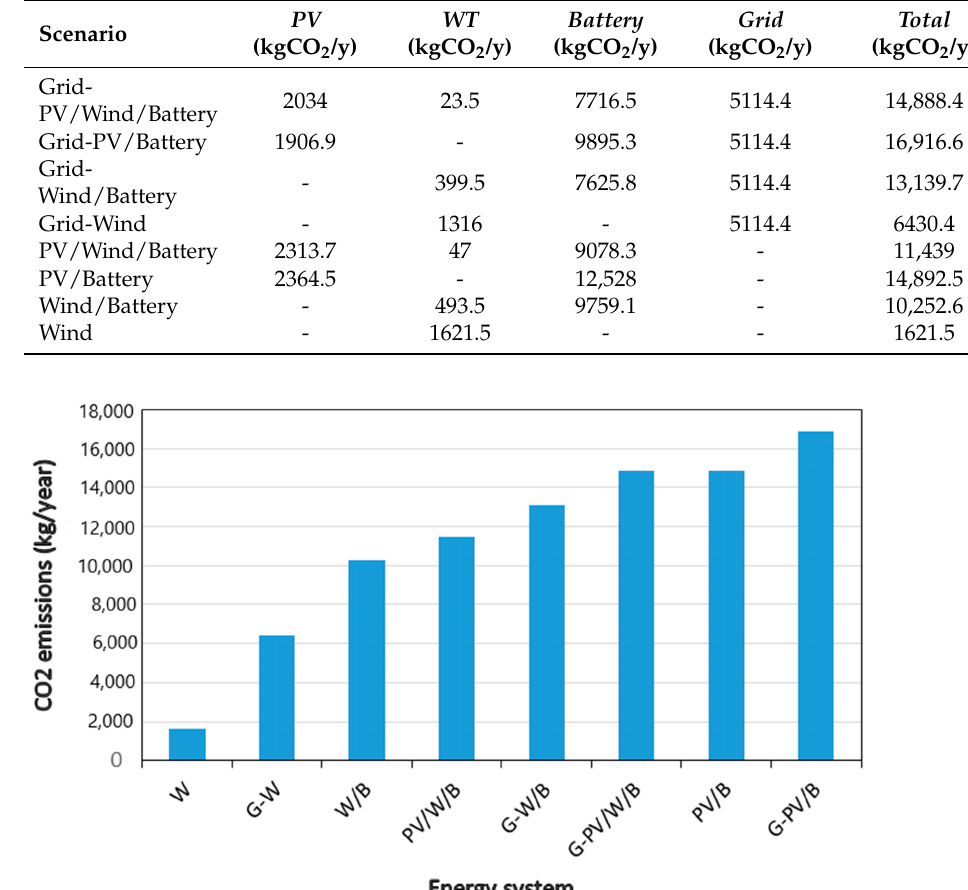
Figure 9. CO 2 emissions from the different studied systems.